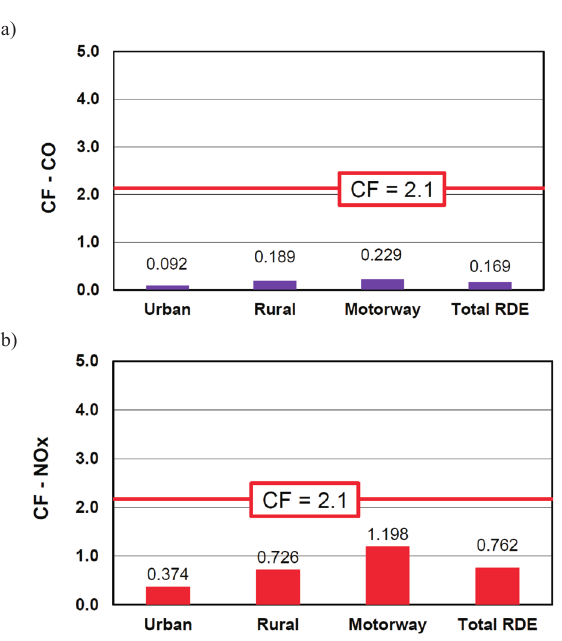
Fig. 10. Conformity factors of carbon monoxide (a) and nitrogen oxides (b) obtained in each test section for vehicle with a gasoline engine